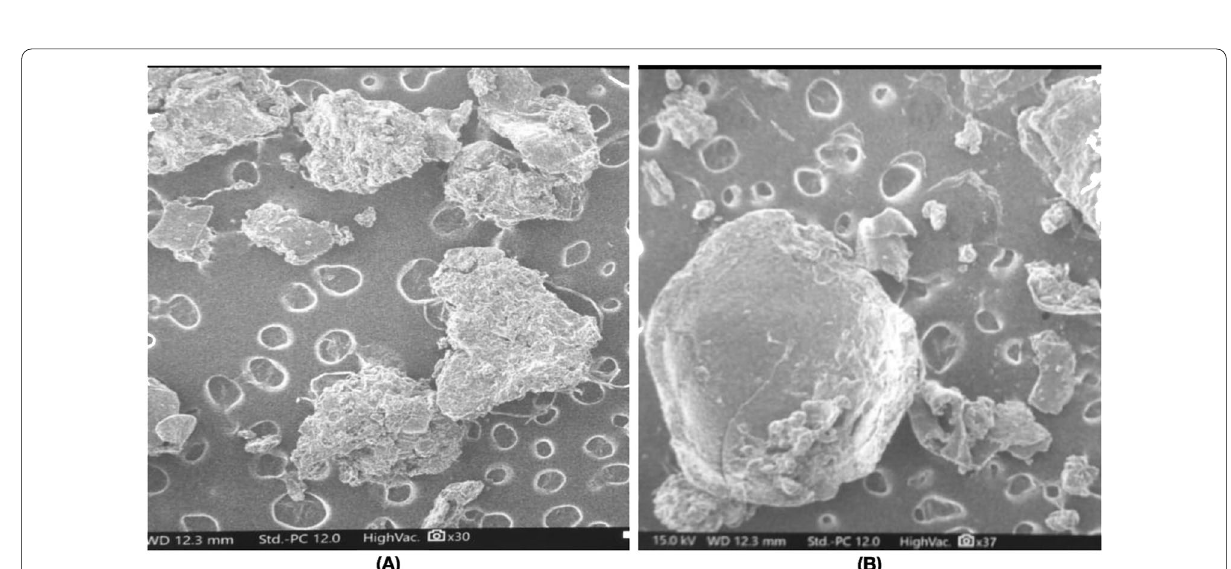
Fig. 6 Scanning electron microscopic images of microspheres. A Blank microspheres, B